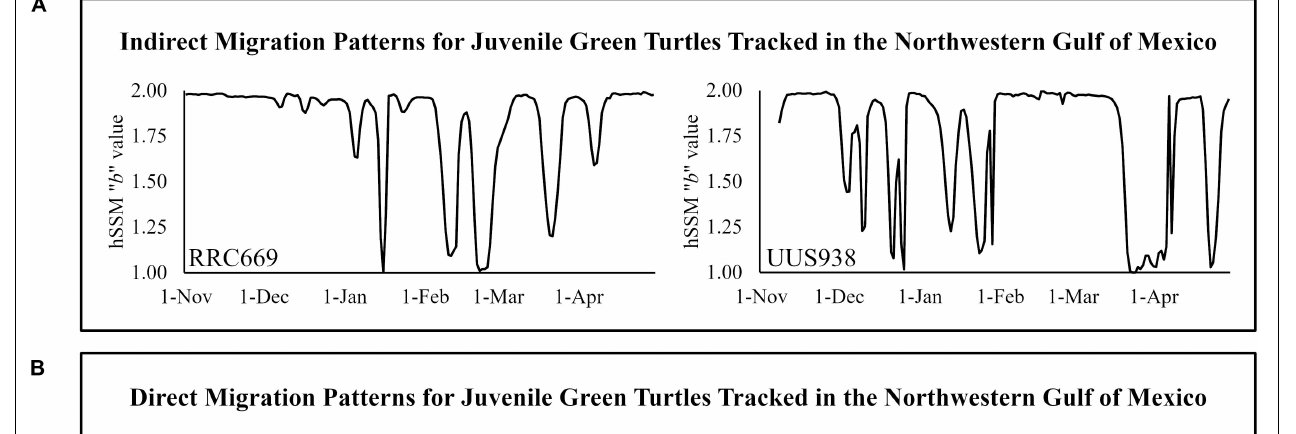
significant hot spot bins occurring in the final time step